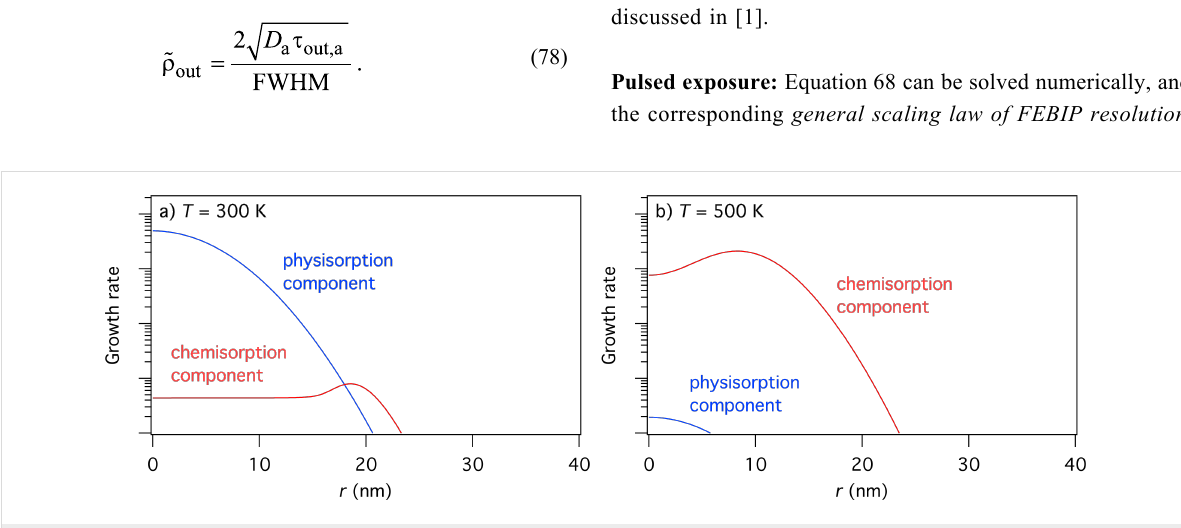
Figure 19: FEBID growth rates simulated using Equation 75 and Equation 76, a Gaussian electron-beam profile ( Ω = 5 nm) and substrate tempera- tures of (a) 300 K and (b) 500 K. (Deposition precursor = TEOS, f 0 = 10 3 Å − 2 s − 1 , P = 0.1 Torr, T g = 300 K, = 0.17 eV, = 0.472 eV, = = 10 11 Å − 2 s − 1 all other model input parameters were the same as in